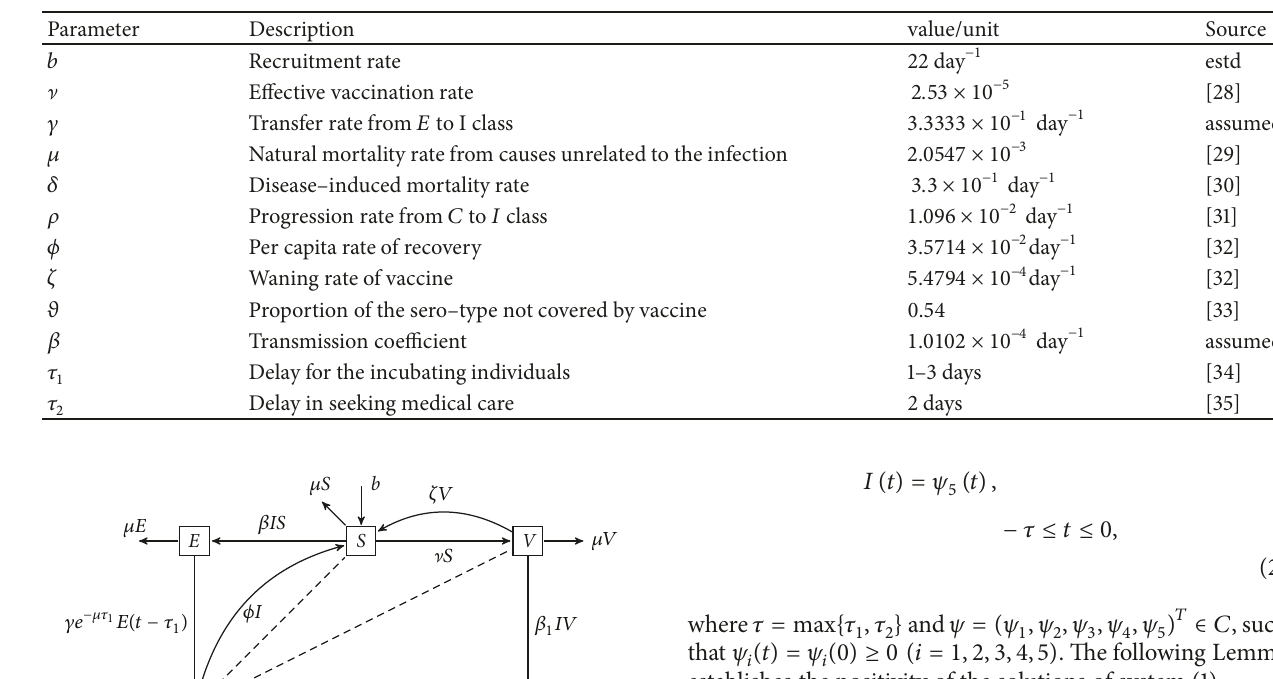
Table 2: Description of parameters.